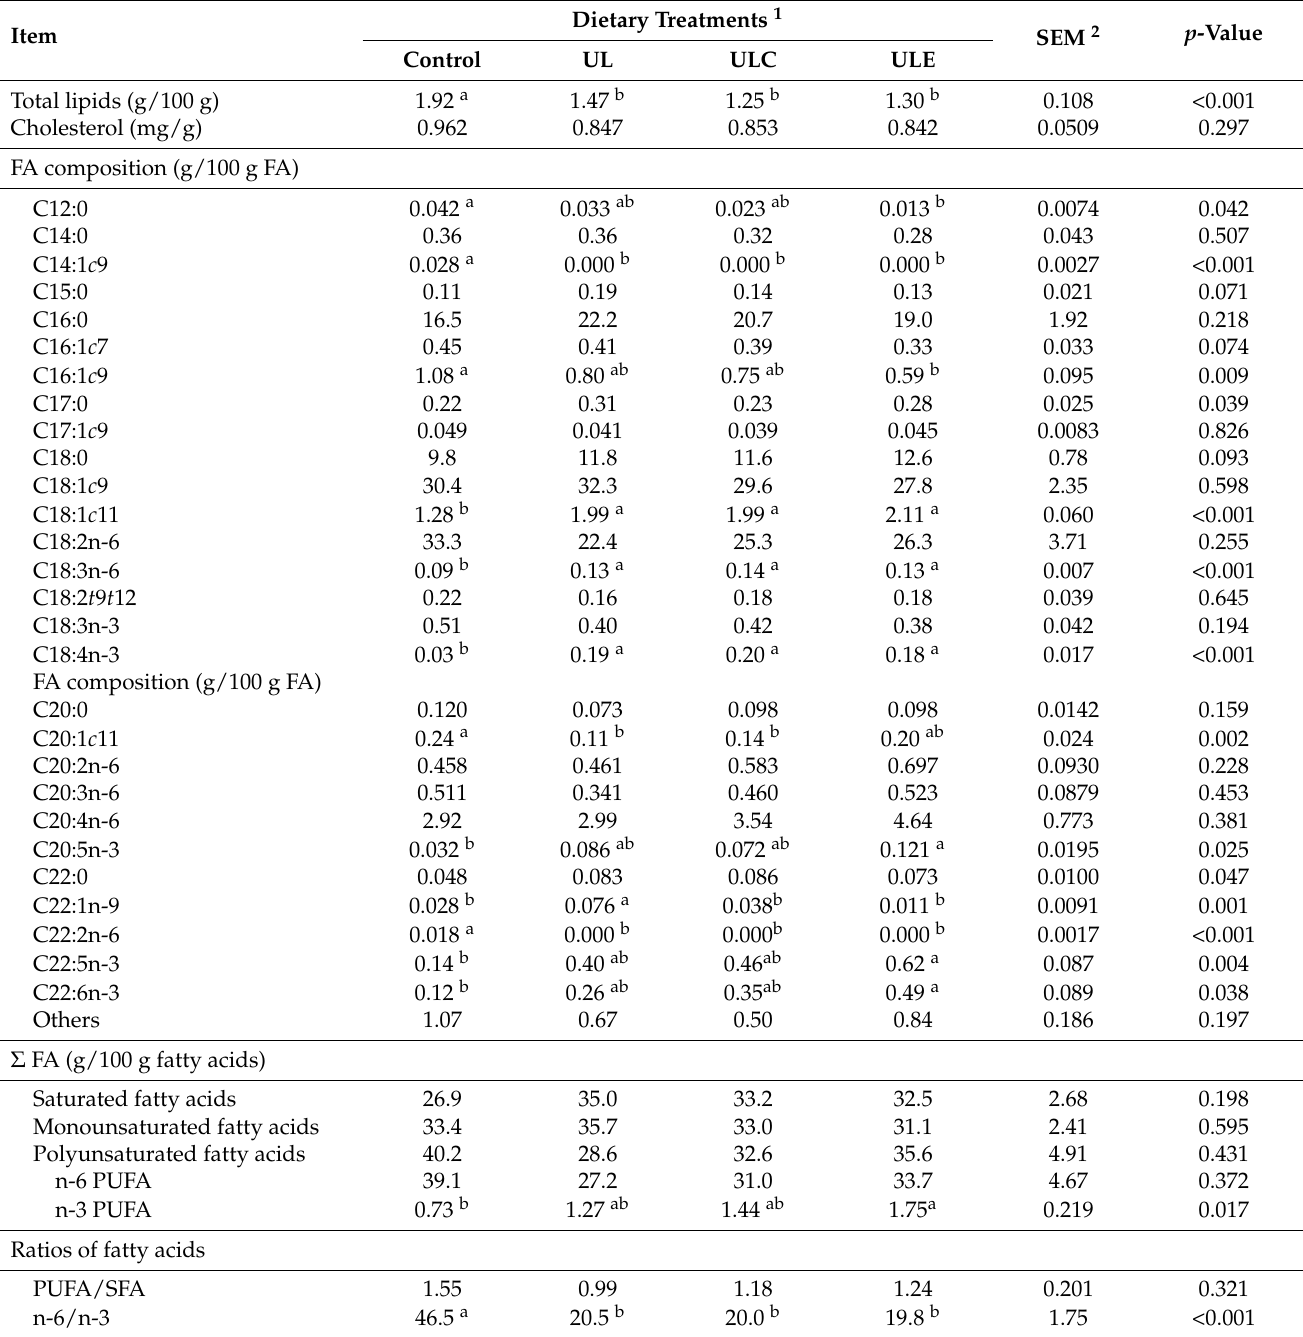
Table 6. Total lipid content, cholesterol content and fatty acid composition in the breast meat of broilers ( n =